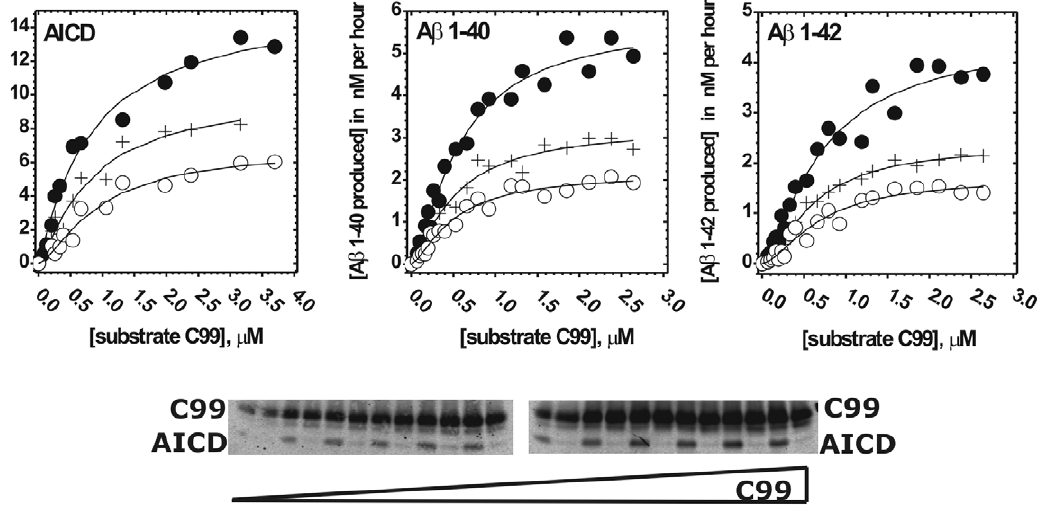
N Figure 3. Michaelis-Menten profiles for AICD, A b 1–40 and A b 1–42 in presence of DAPT. CHAPSO enriched c -secretase membranes were N ), 70 nM ( + ) and 150 nM (O) of DAPT. Michaelis-Menten used to measure Michaelis-Menten profiles for total AICD production in presence of 0 nM ( ), 100 nM ( + ) and 200 nM (O) of DAPT. All profiles have been profiles for A b 1–40 and A b 1–42 production were measured in presence of 0 nM ( analyzed using nonlinear regression and the eqn. 4 (methods). The corresponding best fit values are summarized in Table 2. The gel strips show different concentrations of the C99 substrate and the corresponding AICD products. Alternating in-between are the parallel control reactions in which c -secretase was inhibited by a mix of 10 m M of DAPT and LY-411,575 [3,4]. AICD was measured using antiflag M2 antibodies (as shown in the gel strip). A b 1–40, and A b 1–42 were measured using AlphaScreen H as described in methods section.